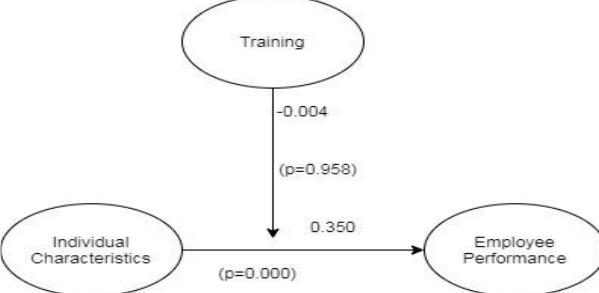
Figure 3. Moderation Test Result of Individual Characteristics Variables on Employee Performance; Source: Processed